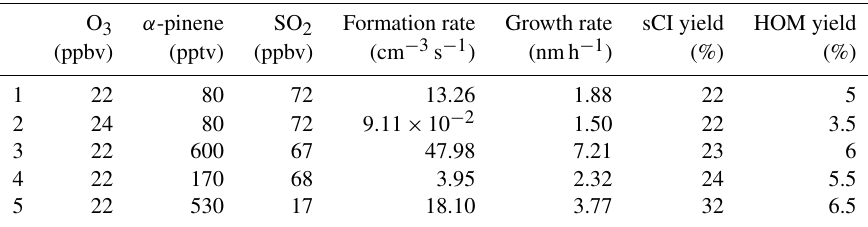
Table 2. The measured concentrations of precursor vapours (ozone, α -pinene and sulfur dioxide), formation rates at 2.5nm, growth rates of particles smaller than 3nm and calculated yields for sCI and HOM during the experiments. O 3 α -pinene SO 2 Formation rate Growth rate sCI yield HOM yield (ppbv) (pptv) (ppbv) (cm − 3 s − 1